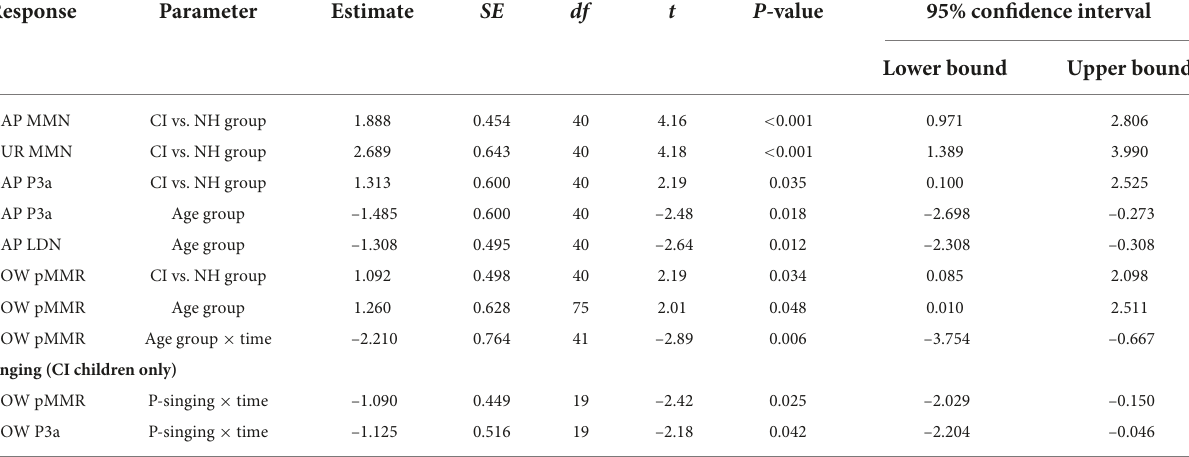
TABLE 5 Estimates of fixed effects, standard errors, t -tests and confidence intervals in the